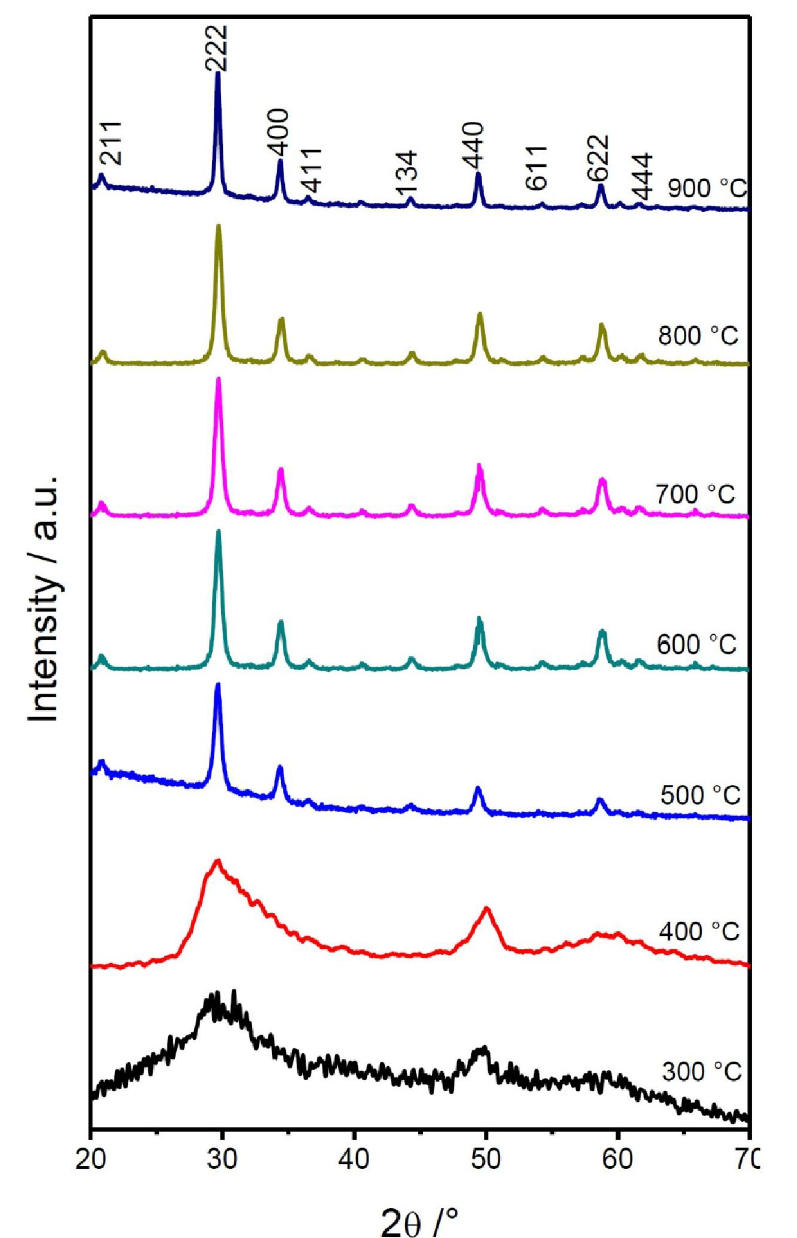
Figure 3. Structural evolution of Lu function of thermal treatment.